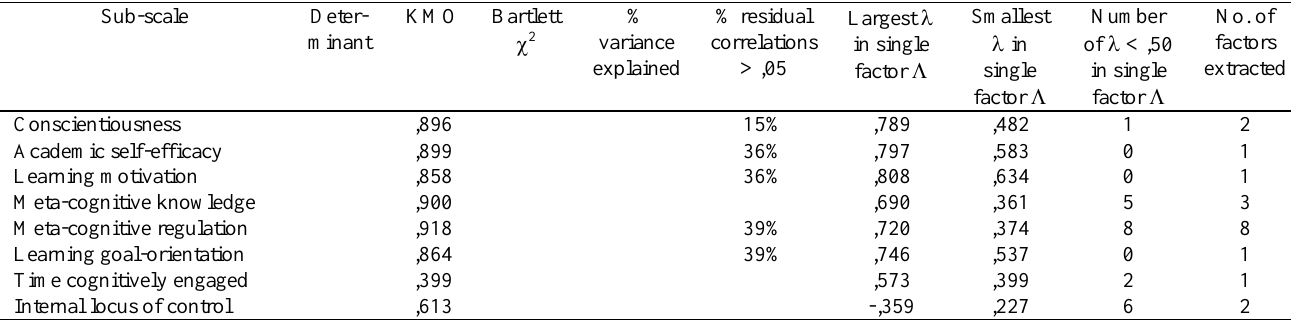
Table 3: Summary of the results of the principal axis factor analyses